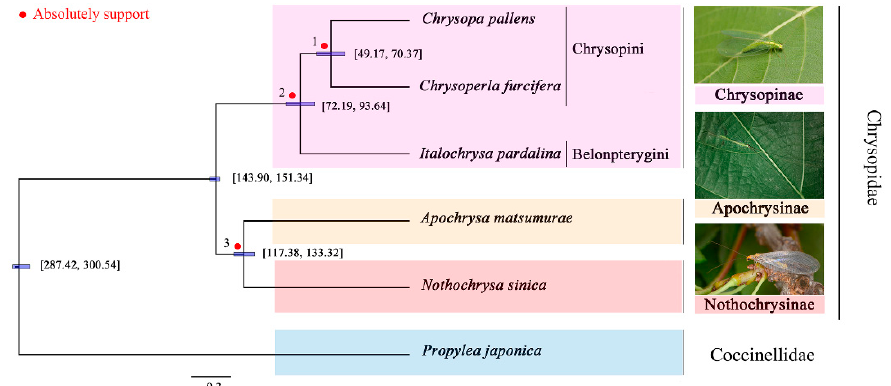
Figure 4. Phylogenetic reconstructions and divergence times of Chrysopidae, based on amino acids with relative composition frequency variability (RCFV) values smaller than 0.1. The concatenated and coalescent analyses of aa as well as the coalescent analyses of nucleotides (NT) all supported this topology. The red dot indicates complete support for the node in all the analyses mentioned above (Node 1, 2, 3). The numbers near each node are the 95% HPD values. Table 4. Node support values of the finial phylogenetic tree, calculated using SH-aLRT replicates and ultrafast bootstraps.